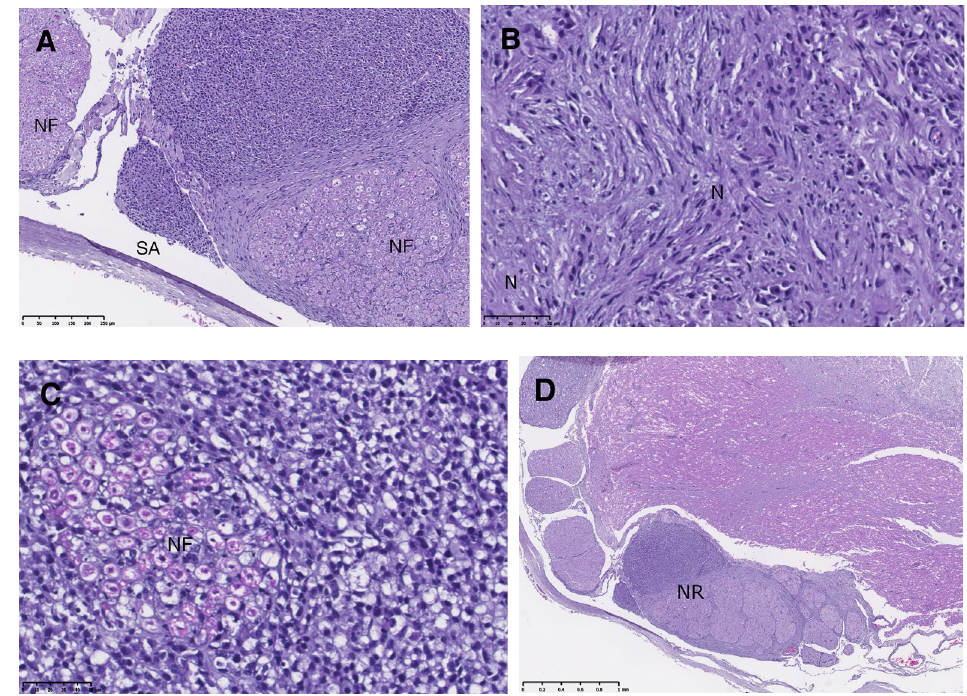
Figure 3. Histological features of the neoplastic lesion confirmed the presence of multiple MPNSTs (Hematoxylin and Eosin, H&E). ( A ) Nerve root invaded by neoplastic cells reaching the subarachnoid space (SA). Nerve fascicles (NF) are also visible. ( B ) Spindle-shaped neoplastic cells (N) population organized in bundles or irregularly distributed. ( C ) Small rounded neoplastic cells growing in a solid pattern and infiltrating nerve fascicle (NF). ( D ) dorsal and ventral roots (NR) thickened and deformed by the neoplastic population, compressing the spinal cord parenchyma.